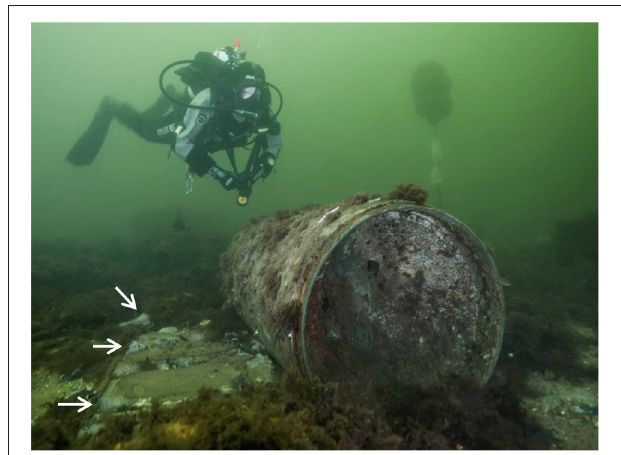
FIGURE 1 | German mine (most likely a BM 1000 parachute mine, Wichert, 2018) on the seafloor in the Baltic Sea, weighing approximately 500kg, with scientific diver for scale. The small gray objects in the sand near the ground mine (arrows) are likely intact, exposed pieces of explosives remaining after low-order detonation of other mines in the area (Photo: J.